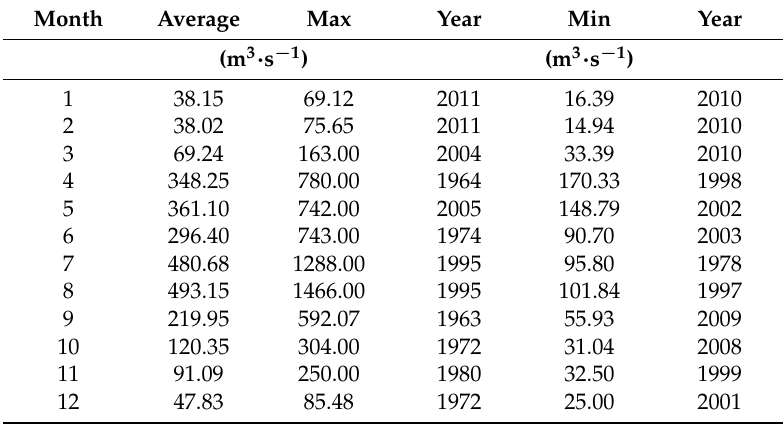
Table 1. The monthly runoff data with simple statistics in 1958~2011.